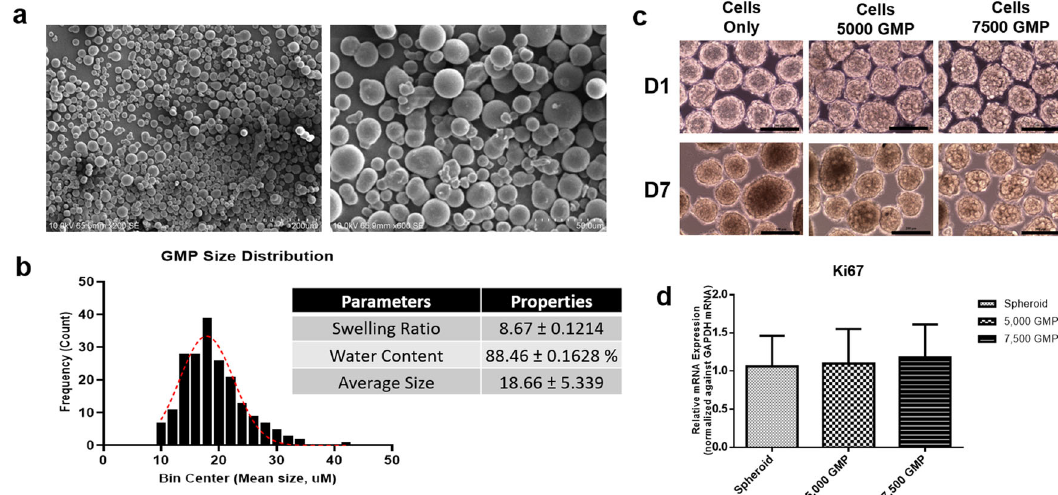
Fig. 2 SEM images, physiochemical properties, and incorporation of gelatin microparticles in ASC spheroids. The GMPs are round, solid, and have a smooth surface with an average diameter of 18.66 ± 5.339 µm ( a, b ). The microparticles have a swelling ratio of 8.84 and water retention up to 85.20%. Incorporation of GMPs (5000 and 7500 GMPs) did not affect the proliferation and did not hinder the spheroid formation of ASCs, as also indicated by the expression of the proliferation marker Ki-67 ( c, d ; scale bars = 200 μ